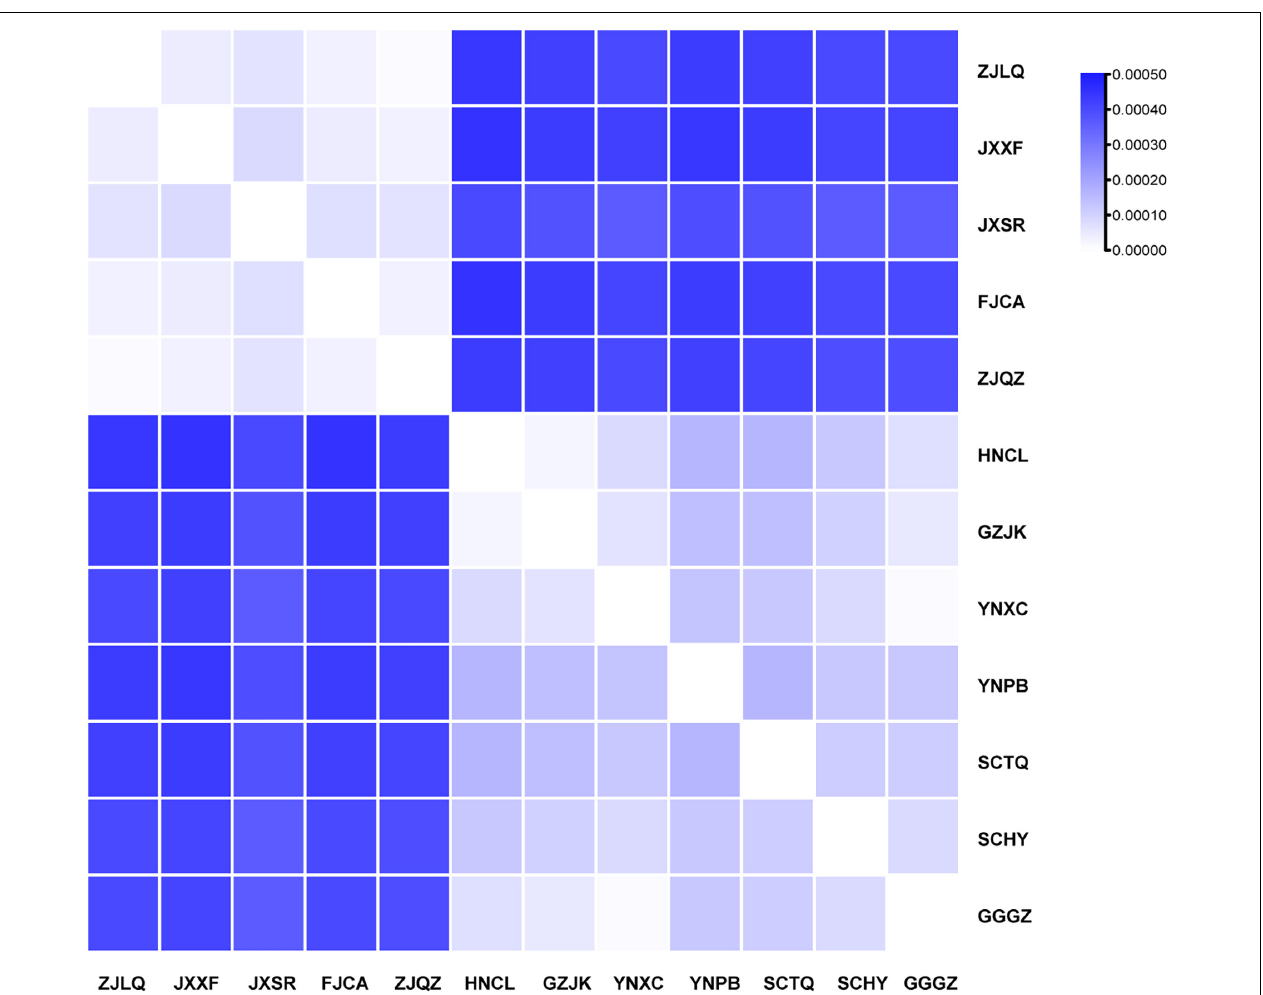
( Figure 9 ). The crown age of Bretschneideraceae was 9.7 Ma in the late Miocene and the two clades of B. sinensis were divergent from 0.6 Ma in the late